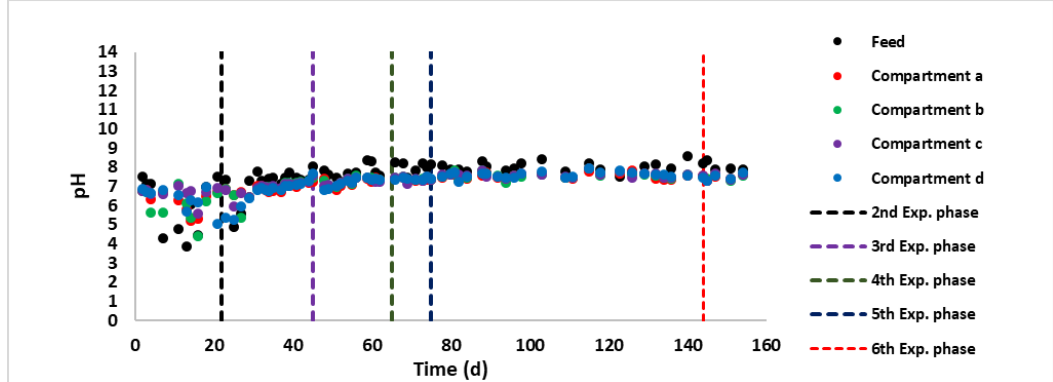
Figure 6 . Daily pH values of feedstock and reactor compartments.